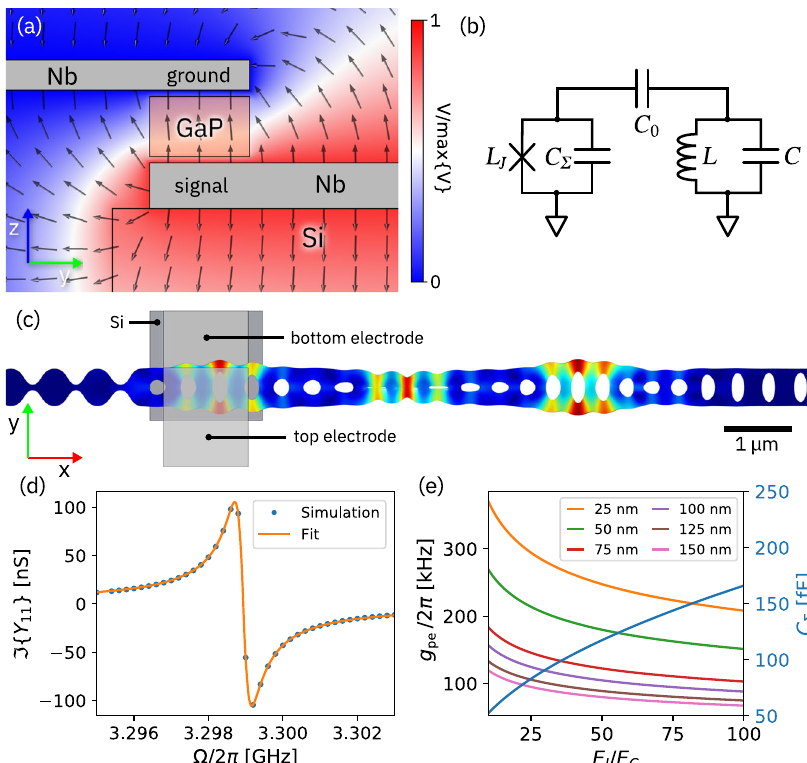
Fig. 6 Theoretical analysis of coupling to a transmon qubit. a Cross-section of a FEM simulation of the electric potential between the microwave signal (red) and ground (blue) electrodes for the optimized geometry. The black arrows indicate the electric fi eld direction. The orange box is the GaP beam. b Circuit representation of a transmon qubit coupled to a parallel LC resonator. c FEM simulation of a mechanical breathing mode showing the electrode geometry. d Imaginary part of the simulated piezoelectric admittance Y 11 (blue) and fi t to an LC resonator (orange). e Calculated qubit shunt capacitance C Σ and coupling rates to a transmon qubit as function of E J / E C for various gap sizes between the electrodes and the photonic crystal